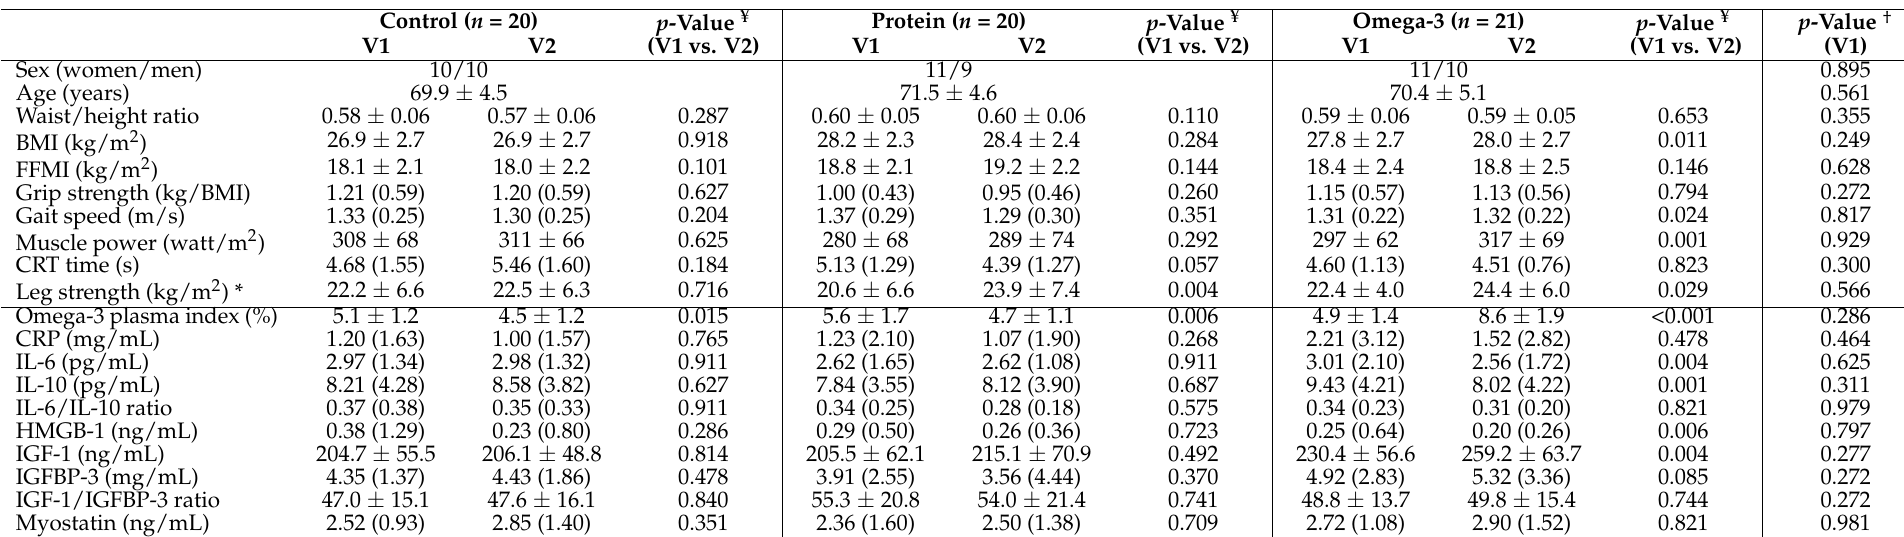
Table 1. Subject characteristics, body composition, physical function, and biomarkers compared between before (V1) and after (V2) eight weeks of control, high-protein (protein) and high-protein plus omega-3 (omega-3)